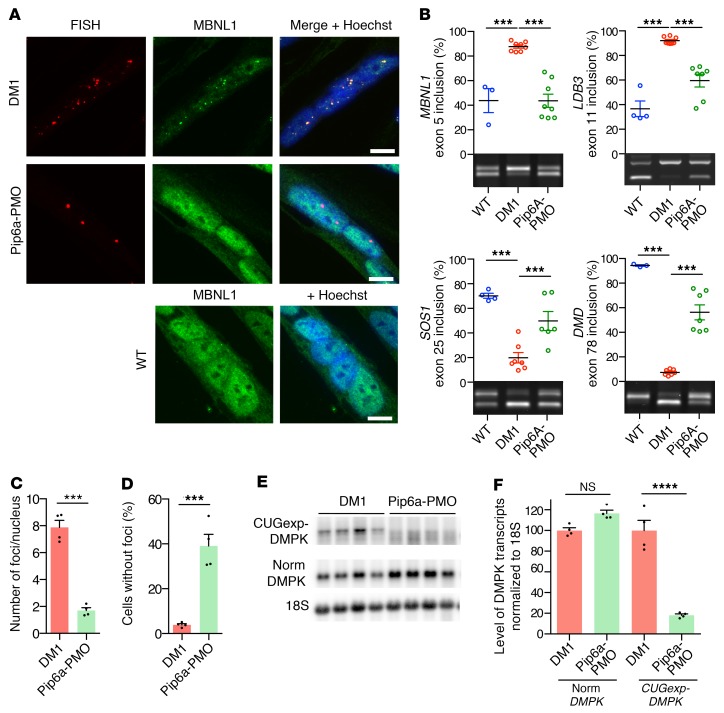
Pip6a-PMO corrects DM1-specific molecular symptoms in DM1 muscle cells.Four-day-differentiated immortalized DM1 myoblasts (2600 CTG repeats) were treated with 1 μM Pip6a-PMO and analyzed after 24 hours. (A) Combined FISH (Cy3-CAG, red) and immunofluorescence (MBNL1, green) on DM1 or WT differentiated myoblasts. Scale bars: 10 μm. (B) Quantification of splicing corrections by RT-PCR (WT n = 4; DM1 and Pip6a-PMO n = 7). (C) Quantification of mean number of foci per nucleus in treated DM1 differentiated myoblasts (n = 4; >500 nuclei per n). (D) Quantification of the number of nuclei without foci in treated DM1 differentiated myoblasts (n = 4; >500 nuclei per n). (E and F) Levels of mutant DMPK and normal DMPK transcripts analyzed by Northern blot using a DMPK probe (n = 4). Data are expressed as mean ± SEM. ***P < 0.001; ****P < 0.0001 by 1-way ANOVA with Newman-Keuls post hoc test (B and F) or Mann-Whitney test (C and D). NS, not significant.